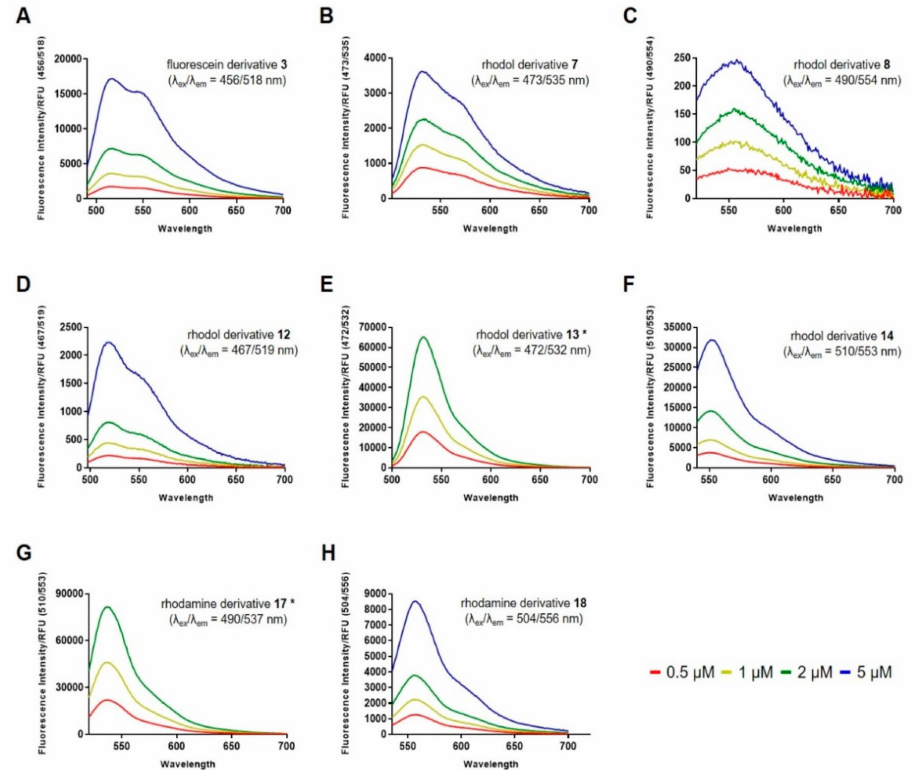
Figure 3. Concentration-dependent fluorescence spectra of asymmetric and reduced xanthene fluorophores in PBS (10 mM, pH 7.4). ( A ) fluorescein 3 ( λ ex / λ em = 456 / 518 nm); ( B ) rhodol 7 ( λ ex / λ em = 473 / 535 nm); ( C ) rhodol 8 ( λ ex / λ em = 490 / 554 nm); ( D ) rhodol 12 ( λ ex / λ em = 467 / 519 nm); ( E ) rhodol 13 ( λ ex / λ em = 472 / 532 nm); ( F ) rhodol 14 ( λ ex / λ em = 510 / 553 nm); ( G ) rhodamine 17 ( λ ex / λ em = 490 / 537 nm); ( H ) rhodamine 18 ( λ ex / λ em = 504 / 556 nm). *Fluorescence of rhodol ( 13 ) and rhodamine ( 17 ) derivatives with monoethylamino group was estimated in the range 0.5 to 2 µ M because fluorescence at 5 µ M is over